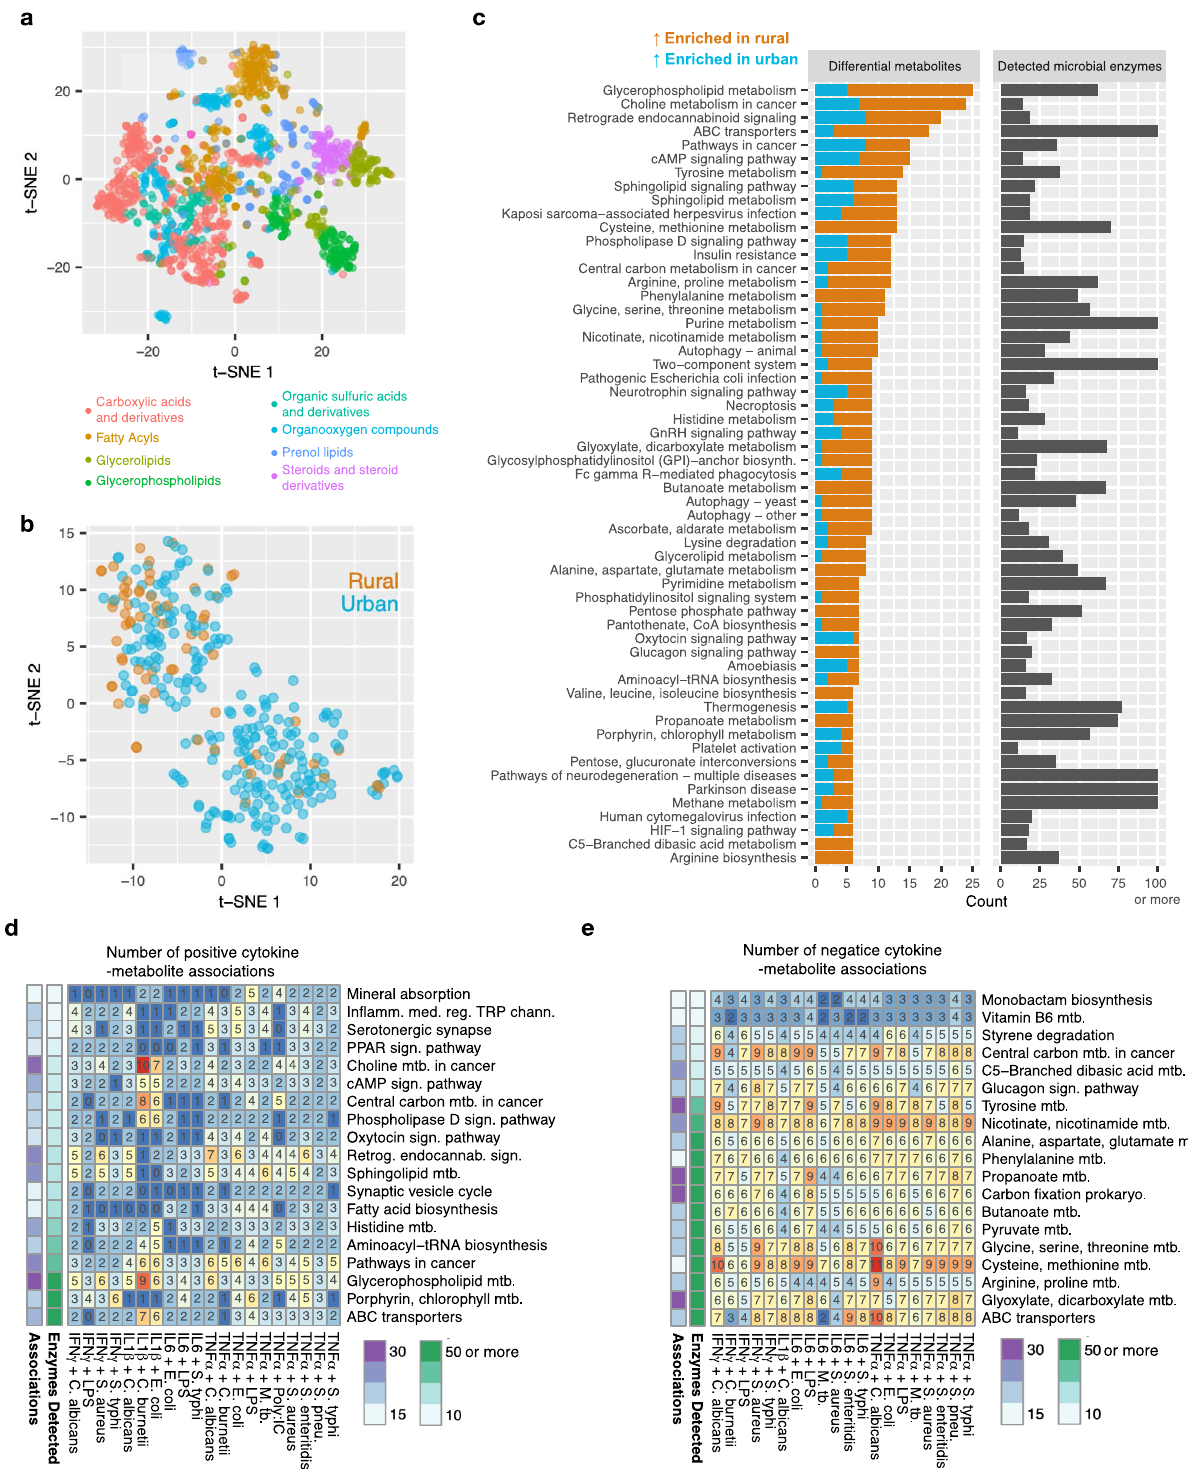
Fig. 4 Pathways with microbial enzymes differentiate the urban/rural metabolome and associate with cytokine responses. a The intensities of 1607 metabolites were standardized (z-scored) across the samples and projected with t-SNE. K-means cluster was used to discover 28 metabolite clusters ( “ Methods ” ) and annotated with the most prevalent HMDB molecular class. b t-SNE plot of samples metabolome pro fi les separating urban and rural samples. c Differentially abundant metabolites between urban and rural samples (Wilcoxon rank-sum two-sided test, P Bonferroni < 0.05), strati fi ed by KEGG pathways. d , e Number of positive and negative effects metabolites on cytokine expression, counted by detected KEGG pathways. Pathways with at least 10 different microbial enzymes in the entire cohort are selected. Metabolite-cytokine correlations are determined by Spearman correlation test subject to P FDR < 0.05. Source data are provided in the Source data fi